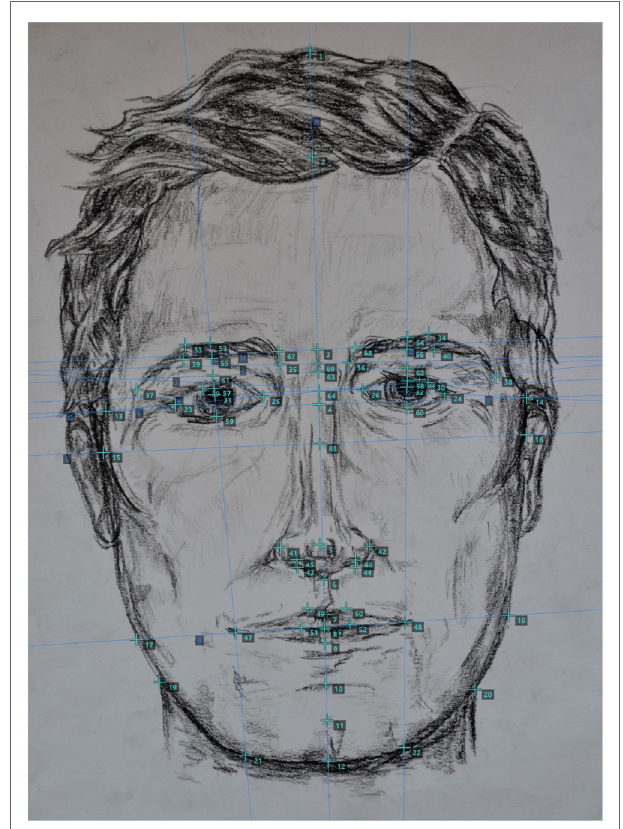
FiGure 1 | Sample drawing showing some examples of possible measuring points on the human face [measured via Face/Palm software